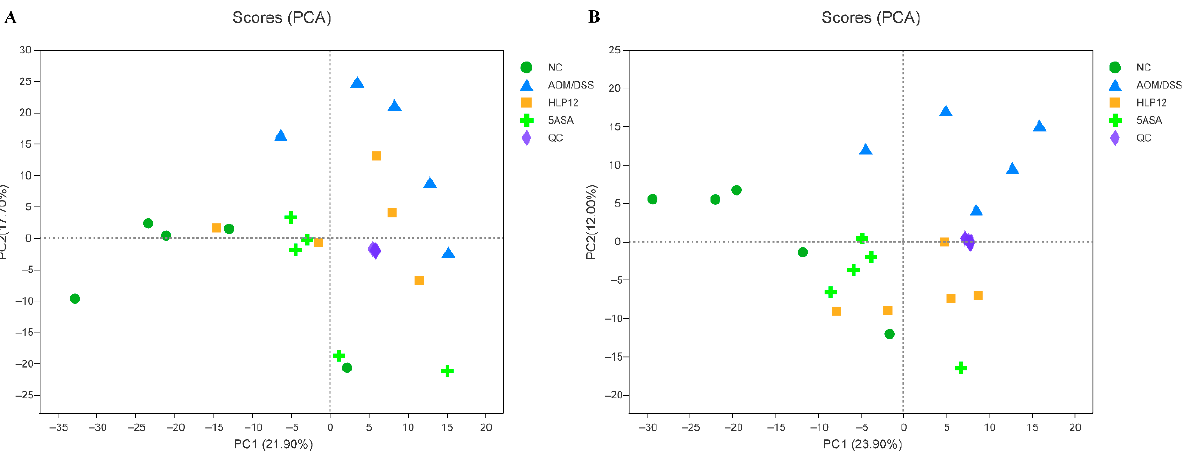
Figure 11. Untargeted fecal metabolomics analysis of AOM/DSS-treated mice ( n = 5). PCA score plot under negative ion mode ( A ) and positive ion mode ( B ).